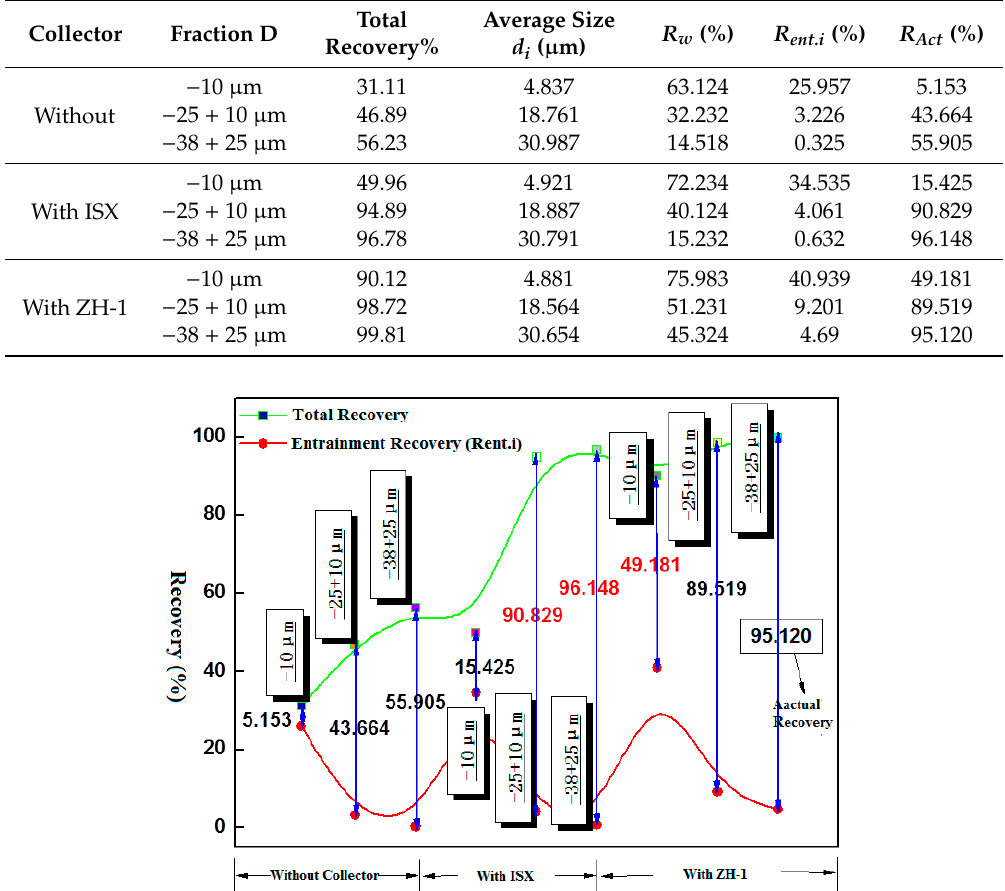
Figure 6. The recovery of true flotation via bubble attachment of the three size fractions in the presence and absence of collector (200 mg/L, pH = 8.5; the red marked represented the best true flotation recovery for the three fractions of malachite).